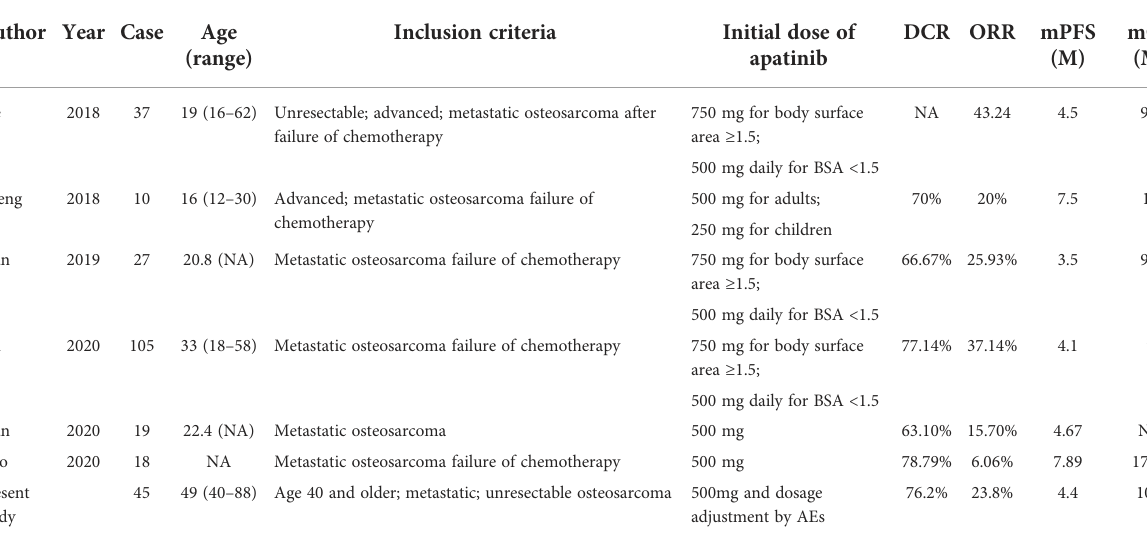
TABLE 4 Recent clinical studies of apatinib treatment for advanced or metastatic